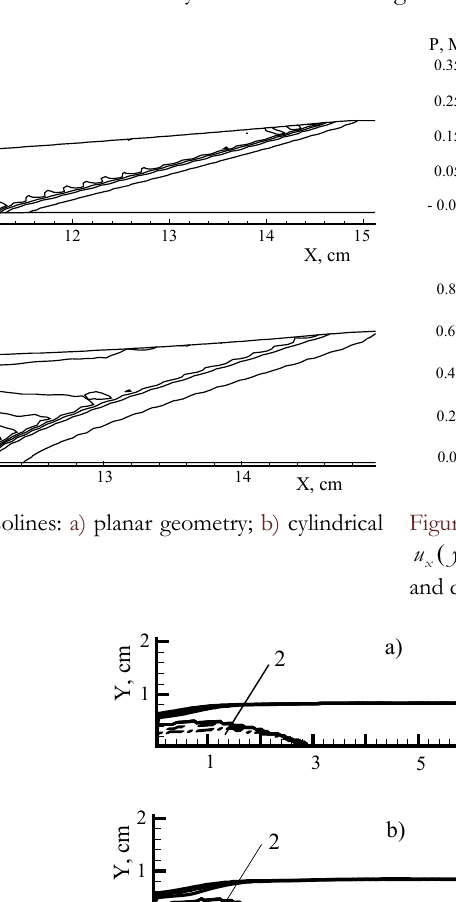
dashed lines in this figure correspond to the planar case and to the cylindrical configuration, respectively. An analysis